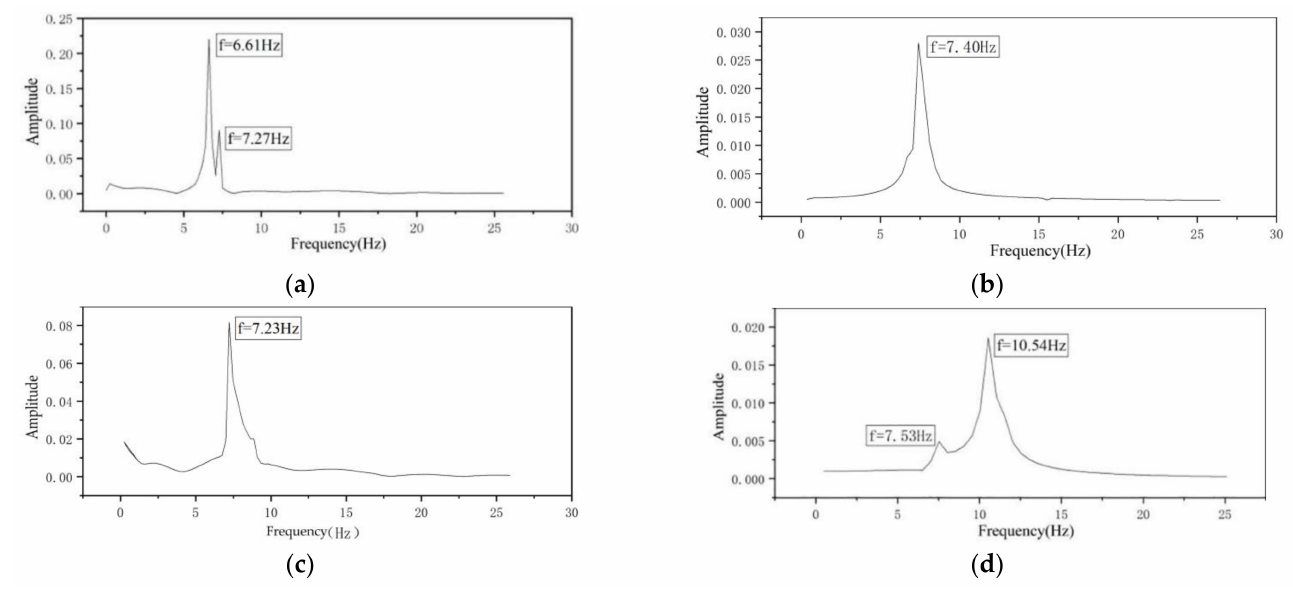
Figure 6. FFT transformation of main beam section displacement curves. ( a ) Reduced wind velocity Vr = 5.18; ( b ) Reduced wind velocity Vr = 6.12; ( c ) Reduced wind velocity Vr = 6.59; ( d ) Reduced wind velocity Vr = 8.47.